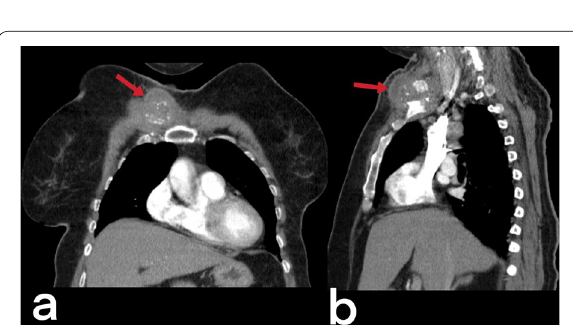
Fig. 51 CT ( a ) and lateral ankle direct X-ray ( b ) images of two different patients. Lytic areas are observed in the tibia in both cases with proven tuberculous osteomyelitis and